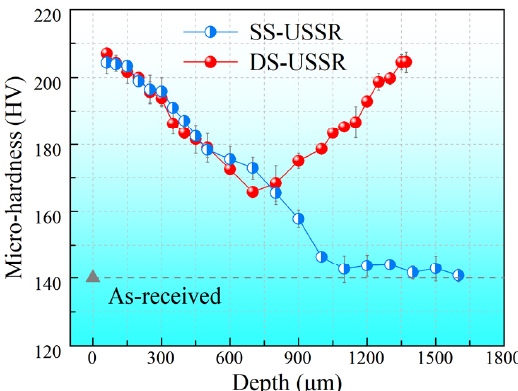
Figure 5. Distribution of micro-hardness along the increasing depth from the topmost surface. For the DS-USSR sample, the depth increases from the first USSR processed side.